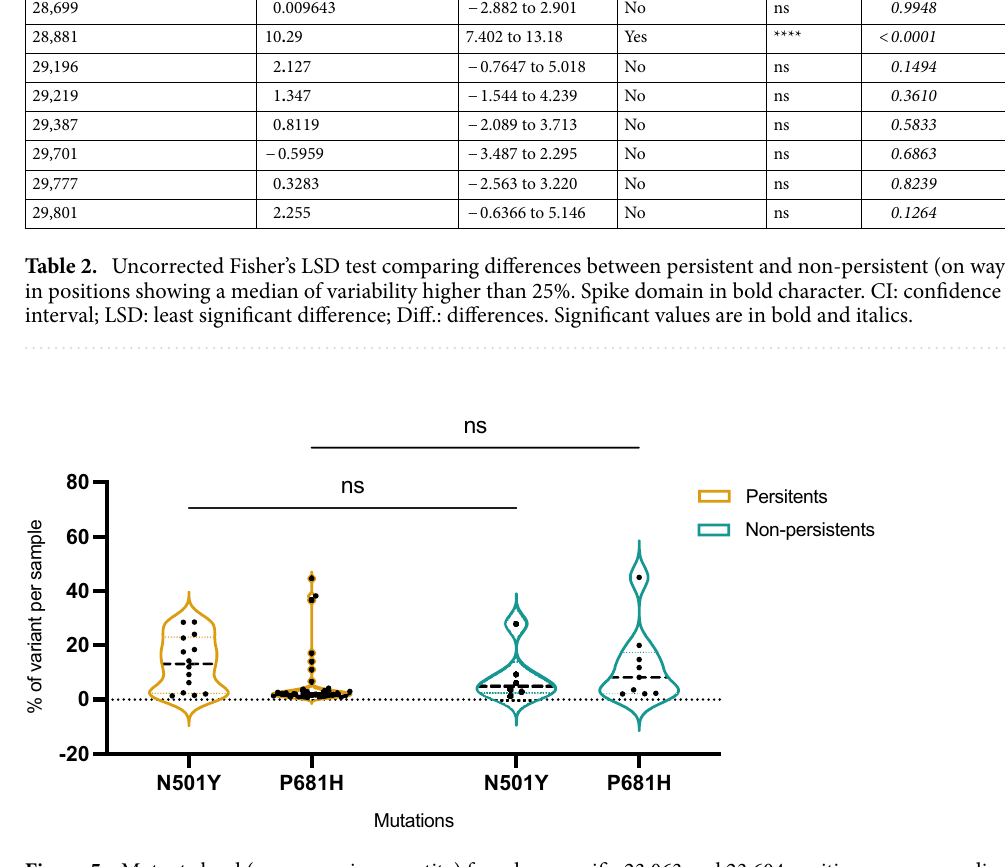
Figure 5. Mutant cloud (non on major quantity) found on specific 23,063 and 23,604 positions, corresponding to N501Y and P681H mutations assessing in patients infected from clades 20A only. Comparison between P and non-P for those position does not show significant